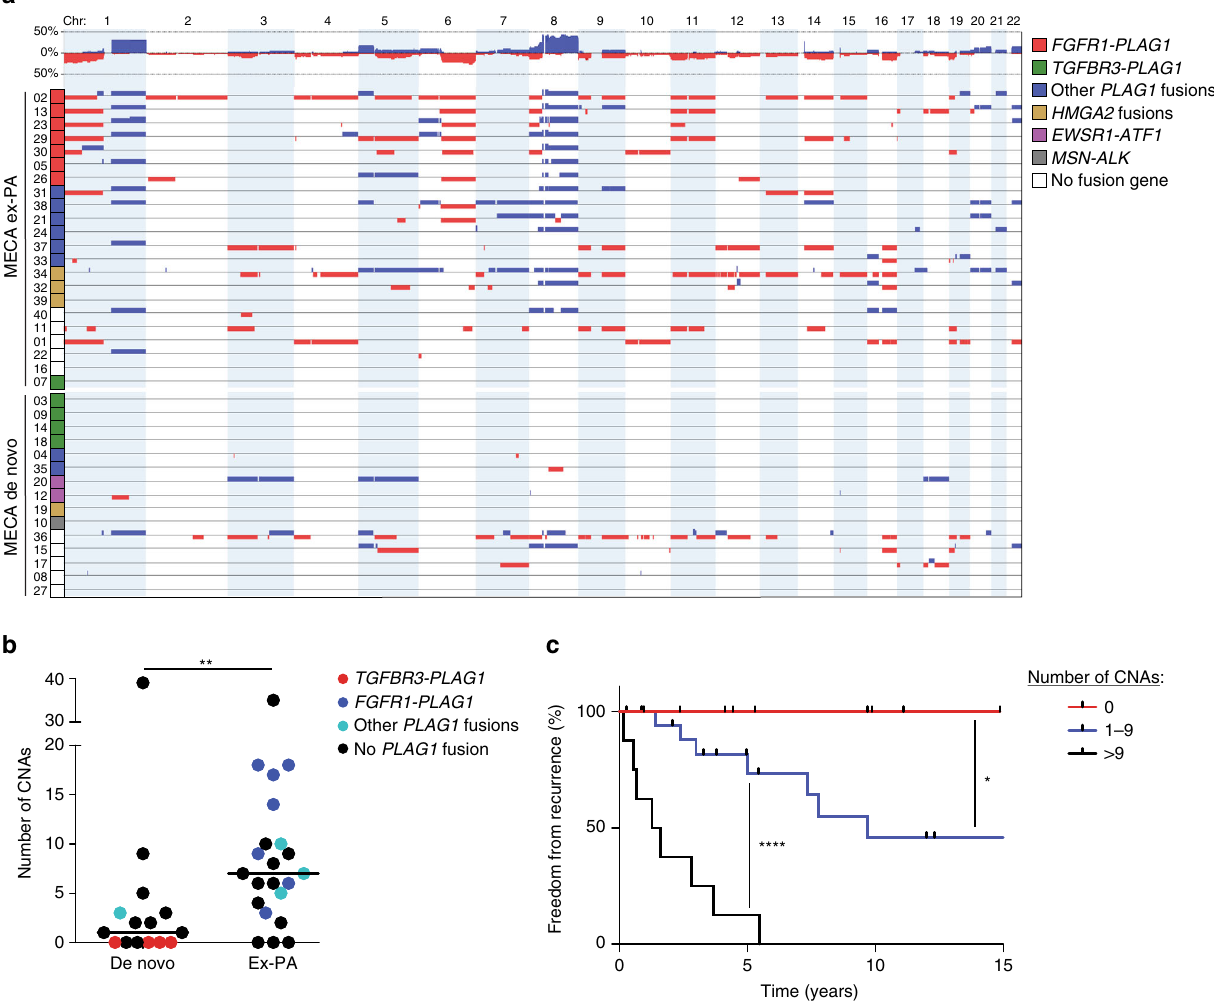
Fig. 6 The number of copy number alterations is associated with tumor origin and prognosis. a All signi fi cant CNAs in MECA tumors, grouped by origin and fusion gene status. b Number of CNAs in MECA de novo and MECA ex-PA tumors. ** P < 0.01; Mann – Whitney test. n = 15 + 22. c Freedom from recurrence in patients with different number of CNAs. * P < 0.05, **** P < 0.0001; log-rank test. n = 9 (0 CNAs) + 20 (1 – 9 CNAs) + 8 ( > 9